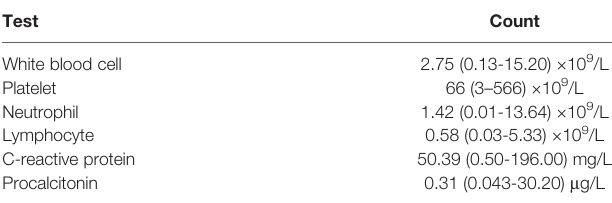
TABLE 2 | Routine laboratory test results of pediatric patients. Test